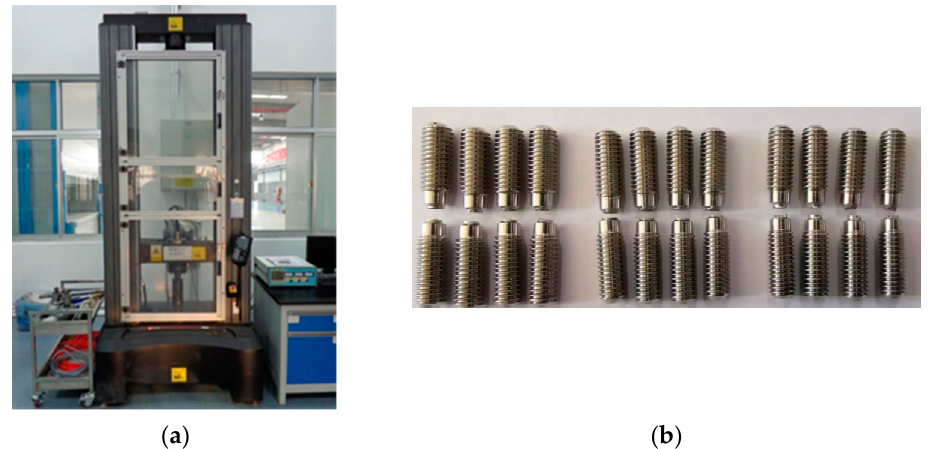
Figure 16. Electronic universal testing machine and tensile test bars. ( a ) Electronic universal testing machine. ( b ) V-shaped, arc-shape and square tensile test bars. Table 5. Comparison of simulation and test results for different notch structures.